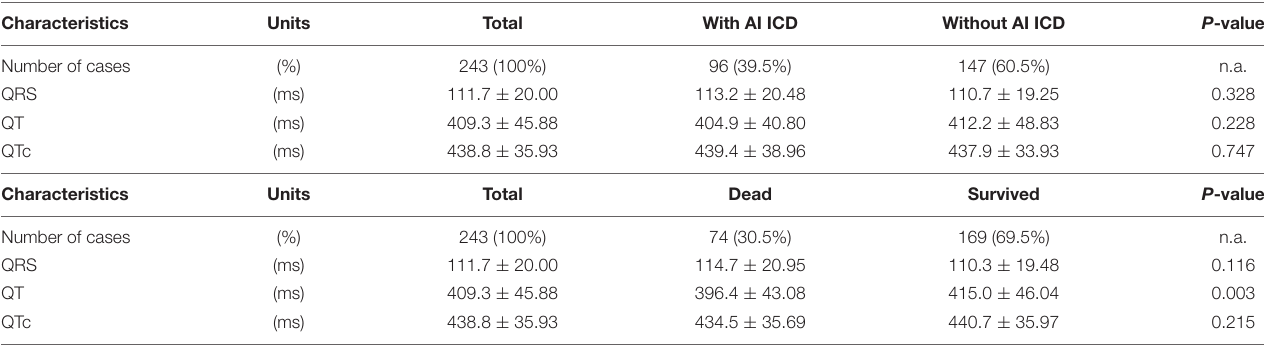
TABLE 3 | Duration of QRS complex and QT(c) intervals in studied patients